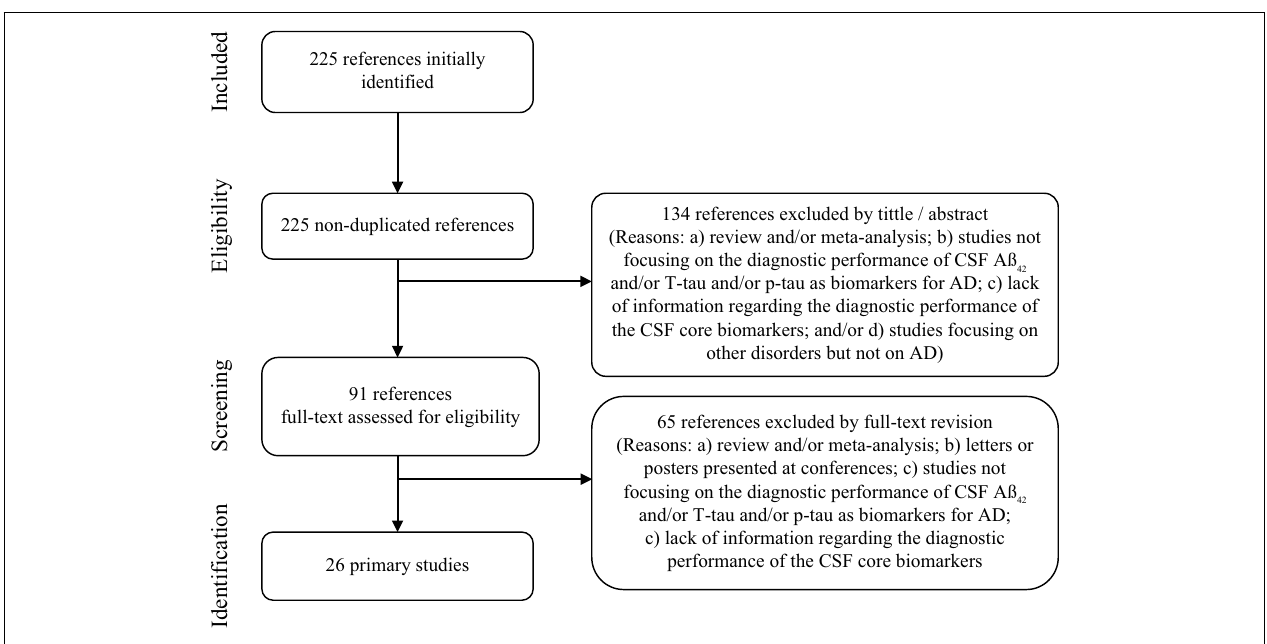
FIGURE 2 | Study selection flow for primary studies published after the new revised diagnostic criteria .